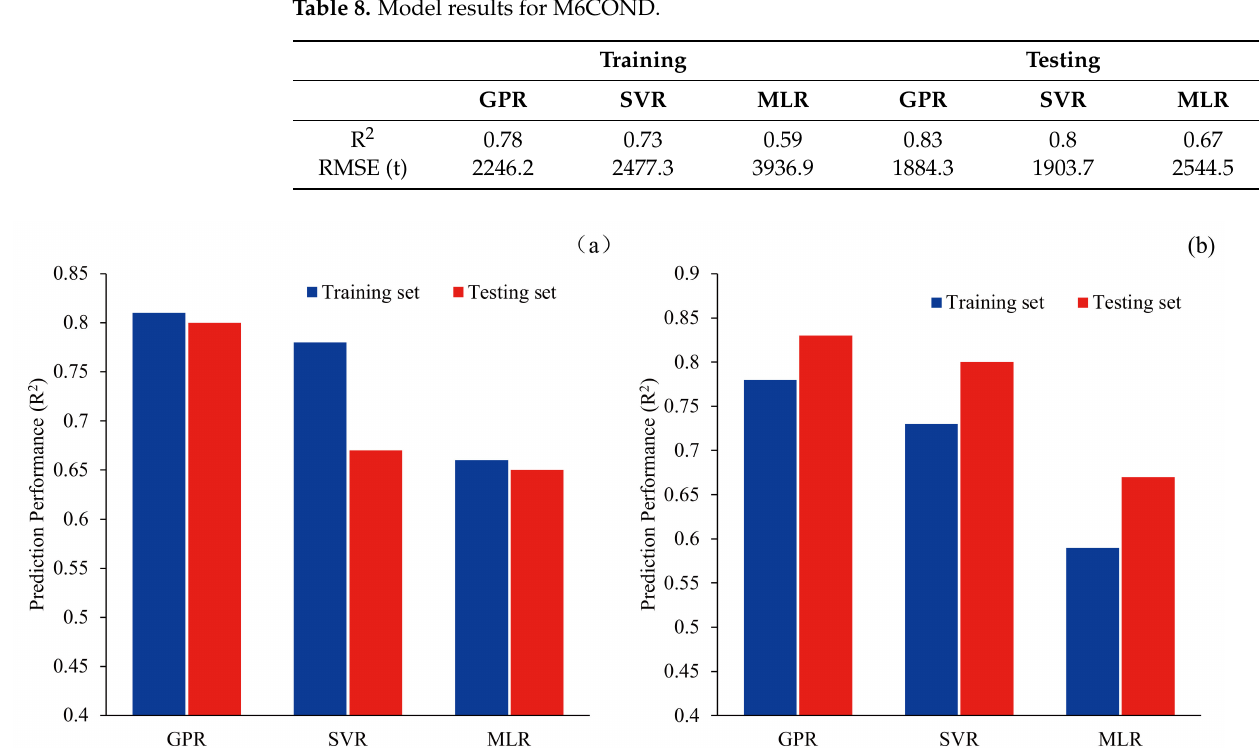
Figure 5. Comparison of prediction performance of the GPR, SVR, and MLR algorithms: ( a )prediction performance about M6GAS ( b ) prediction performance about